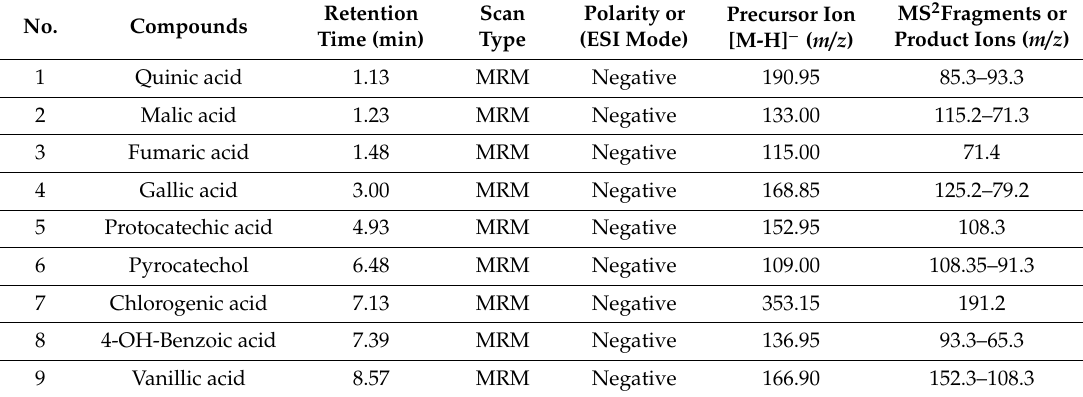
Table 1. HPLC–MS / MS acquisition parameters used for the analysis of the 37 marker compounds in the extracts of Hypochaerislaevigata var. hipponensis